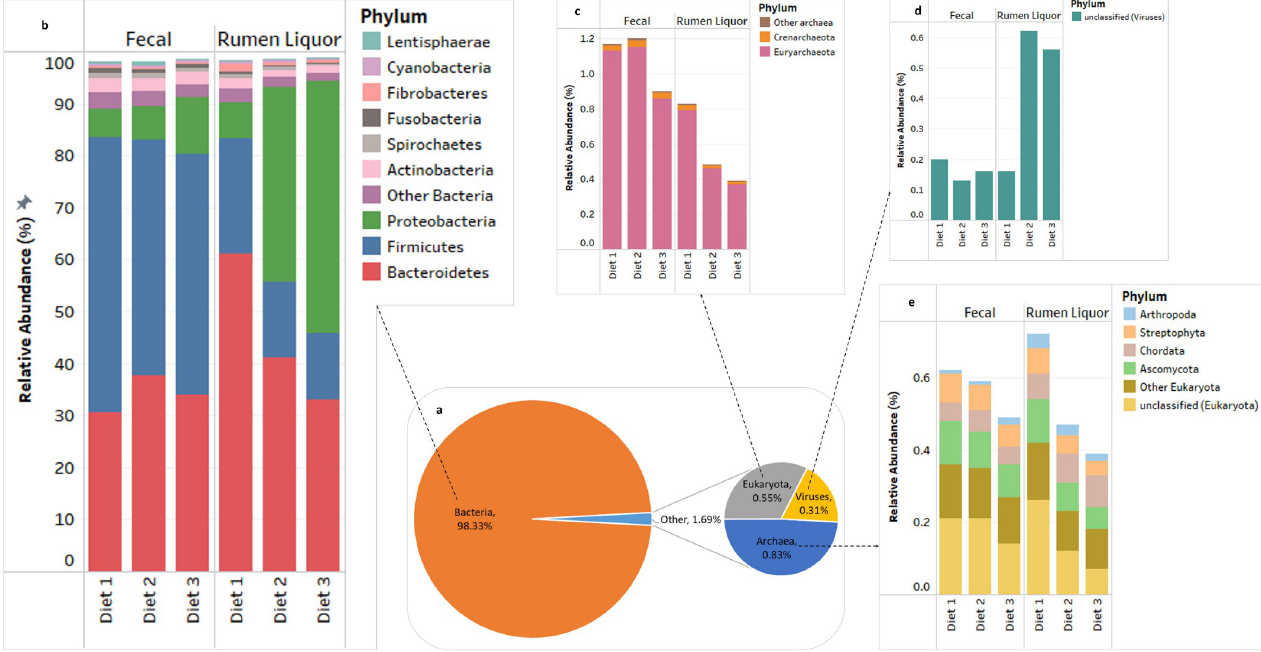
Fig 1. Phylogenetic classification of the rumen microbiome as revealed by metagenomic analysis. a . Pie chart for microbial classification at the domain level. Averages are from all fecal and rumen liquor samples. b . Stacked bar plot of relative abundance of the top 10 bacterial phyla in the three diets for fecal and rumen liquor samples. c. Stacked bar plot of relative abundance of the dominant phyla in Archaeal domain. d. Stacked bar plot of relative abundance of one dominant phylum in viral domain, and e. Stacked bar plot of relative abundance of the dominant phyla in the Eukaryota domain.